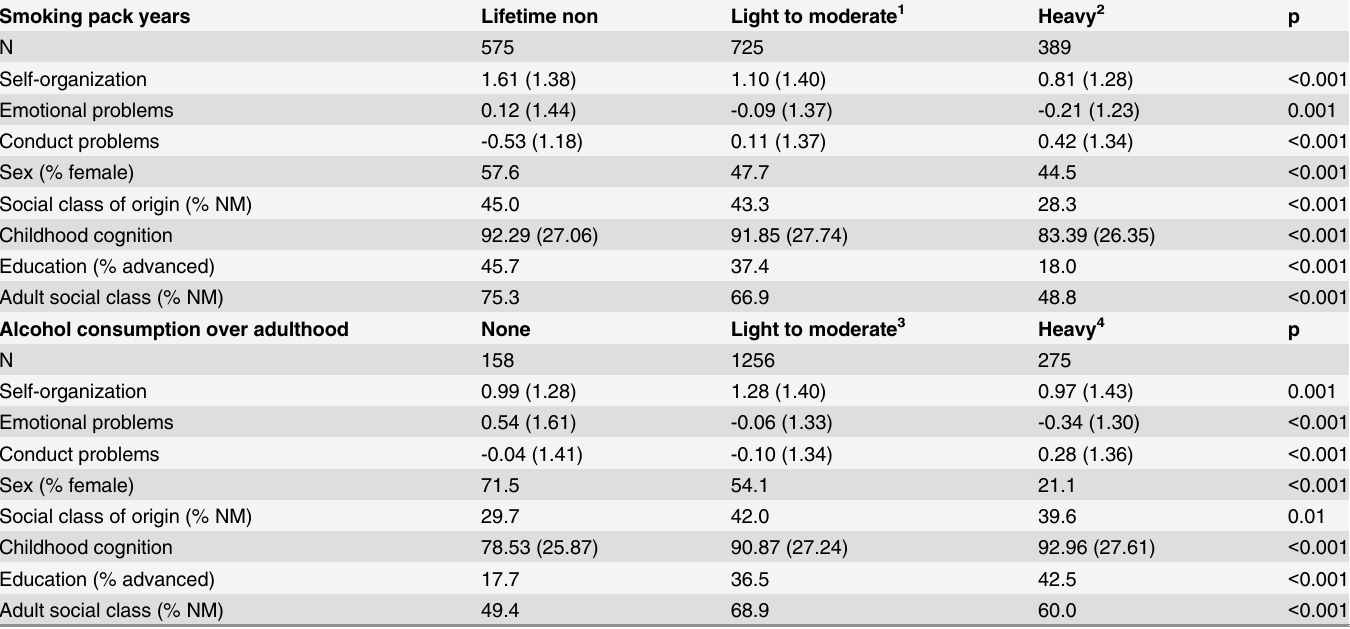
Table 1. Descriptive information (means and SDs or proportions) and corresponding p values for bivariate between-group tests for each health behavior. Smoking pack years Lifetime